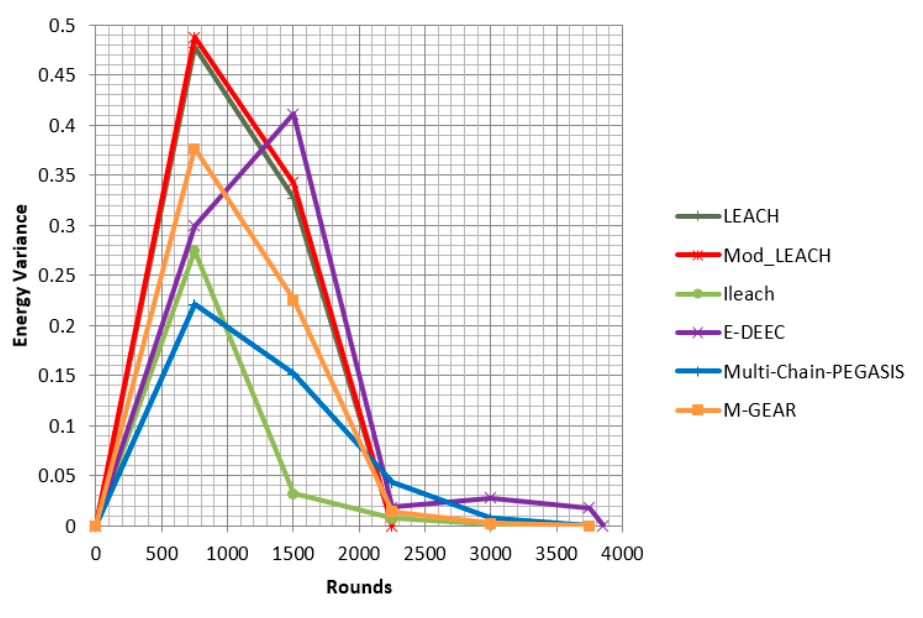
Figure 7. Variance versus rounds.